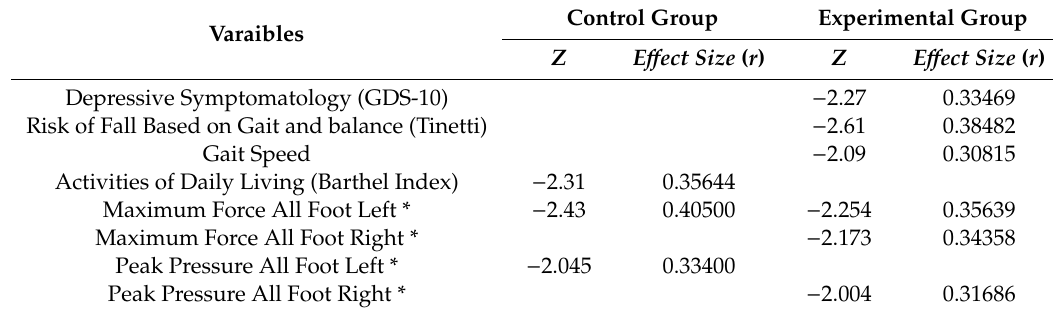
Table 4. E ff ect size